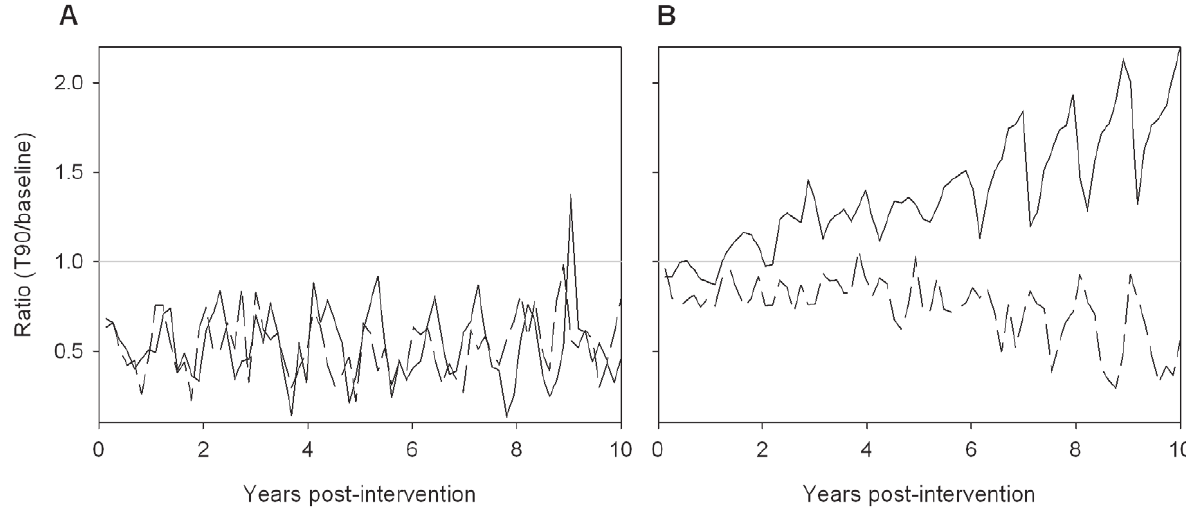
Figure 4. Simulated impact of T90 intervention on parasitemia. Data are expressed as the ratio of mean number of patent ( $ 100 parasites/ m l; dashed line) or sub-patent ( , 100 parasites/ m l; solid line) infections to baseline in (A) 0–3 year olds and (B) . 14 year olds. Values , 1 represent fewer infections under the intervention compared to baseline, while . 1 represents more infections under the intervention.